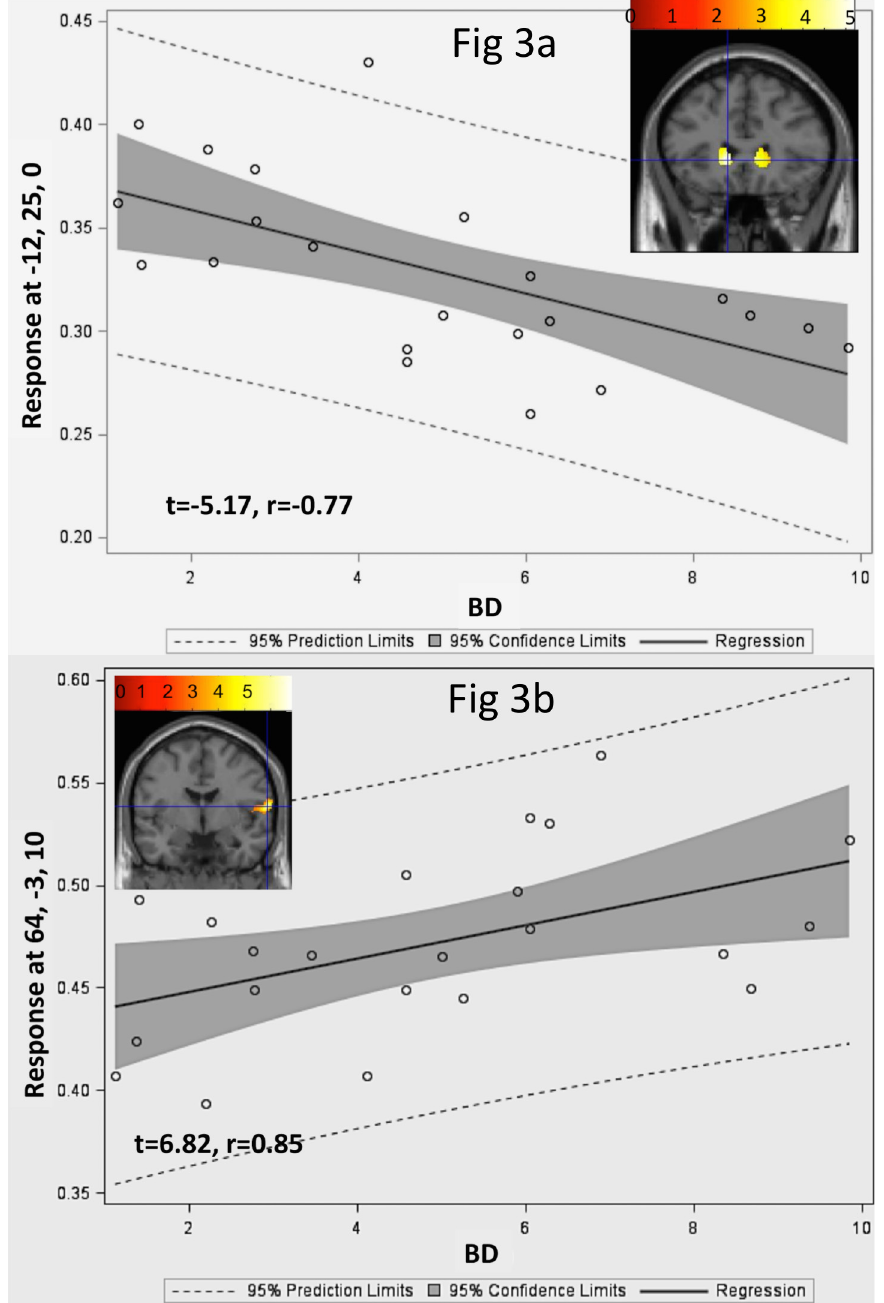
Fig 3. Whole brain regression analyses with BD within patients. Color map (Y coordinate: 25 mm) in Fig 3a showing negative association between the bilateral striatum and BD score in patients after co-varying for age and IQ. Color map (Y coordinate = -3 mm) in Fig 3b showing positive association between the insula and BD score in patients after co-varying for age and IQ. The crosshairs mark the voxel with maximum association and the regression plots below the color maps show the association between the region and BD score for that voxel with maximum association. A 95% confidence interval will contain the true parameter (slope) with probability 0.95. The prediction interval is an estimate of an interval in which future observations will fall, with probability 0.95, given what has already been observed. Rt =